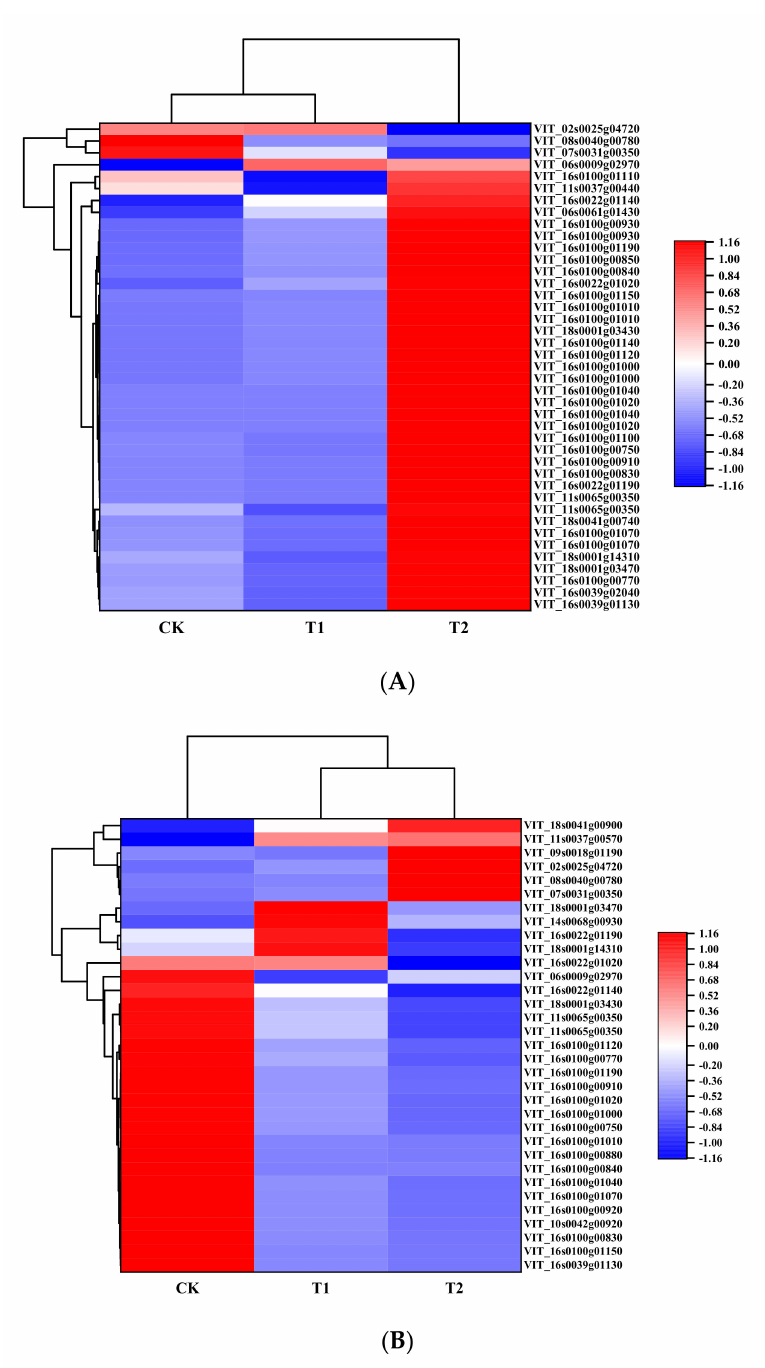
Figure 4. Expression pattern of differentially expressed genes (DEGs) involved in flavonoid synthesis. ( A ) Candidate structural genes related to flavonoid biosynthesis at 90 DAFB. ( B ) Candidate structural genes related to flavonoid biosynthesis at 110 DAFB. The Z-score value is represented by the depth of color, with red representing upregulation and blue representing downregulation. The PAL , CYP73A , 4CL , F3H, and UFGT gene expression of grapes in the T2 treatment was significantly higher than the gene expression of grapes in the T1 and CK treatments at 90 DAFB. The lowest FPKMs of the PAL , CYP73A , 4CL , F3H , and UFGT genes